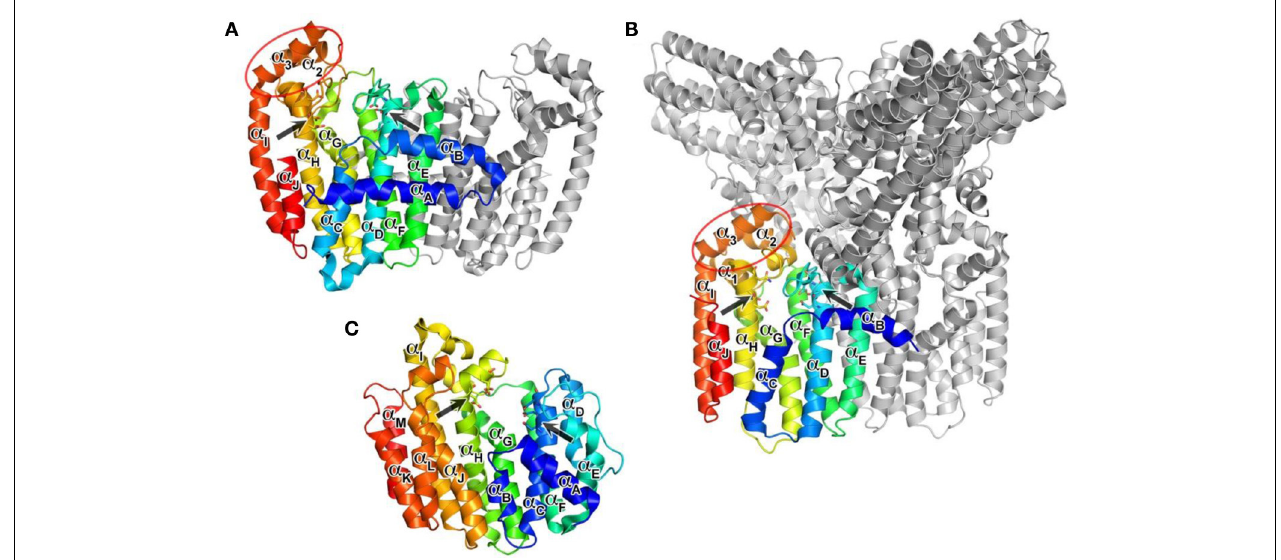
FIGURE 3 | Overall structures of human prenyl synthase enzymes. (A) Farnesyl pyrophosphate synthase (PDB ID: 2F7M); (B) geranylgeranyl pyrophosphate synthase (PDB ID: 2Q80), and (C) squalene synthase (PDB ID: 3WEG). The enzymes are shown in a blue-to-red rainbow color scheme. For hFPPS and hGGPPS, one monomeric subunit of the enzyme